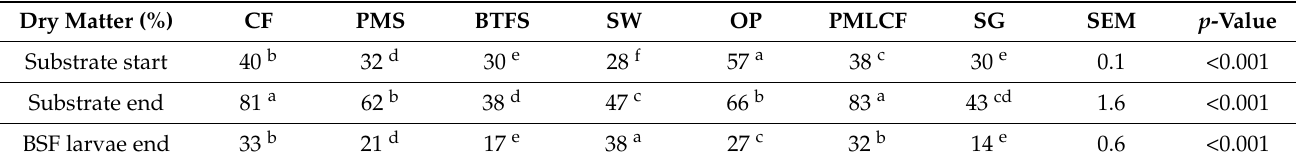
Table 2. Dry matter content of the substrates 1 at start and end of the experiment and dry matter content of BSF larvae at end of the experiment.